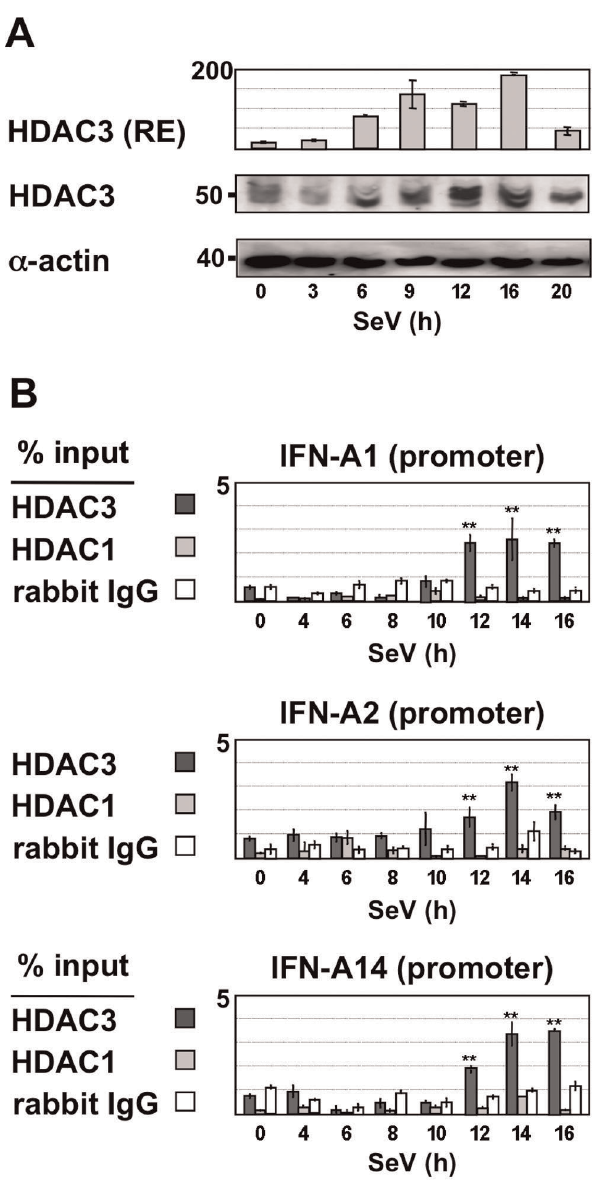
Figure 4. Recruitment of HDAC3 to IFN-A gene promoters during virus infection. ( A ) Relative expression levels of HDAC3